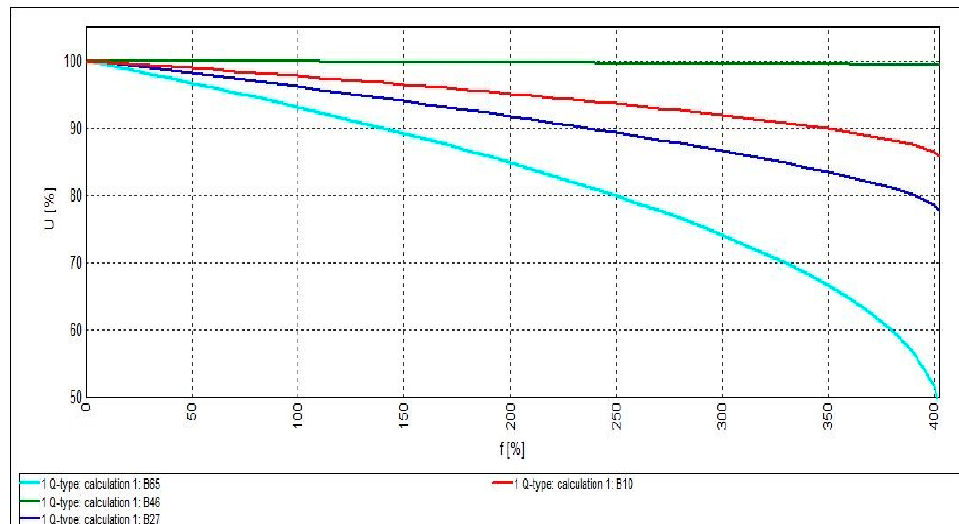
Figure 7. PV curves of the IEEE 69 ‐ node RDS system with 1 Q ‐ type DG installation.